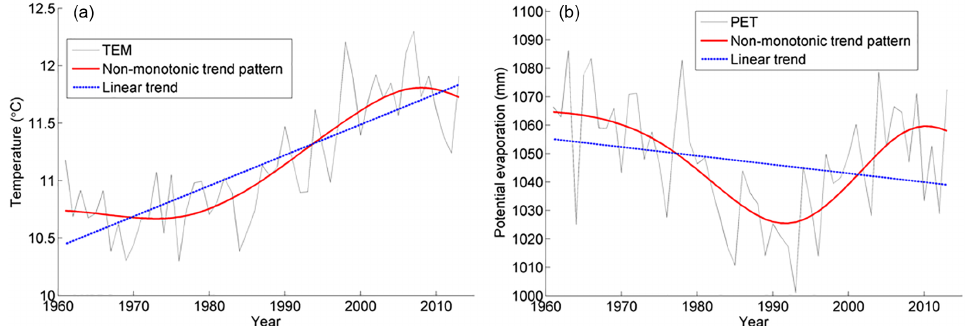
Figure 4. Non-monotonic trends in the annual time series of the mean air temperature (TEM, a ) and the potential evaporation (PET, b ) over China from 1961–2013 identified by the discrete wavelet spectrum (DWS) approach, and the linear trends in the two